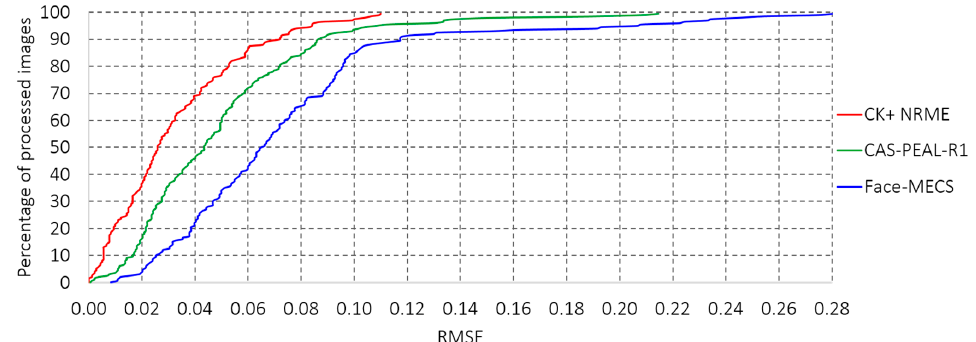
Figure 12. Root-Mean-Squared Error obtained by applying the AAM in the proposed databases.